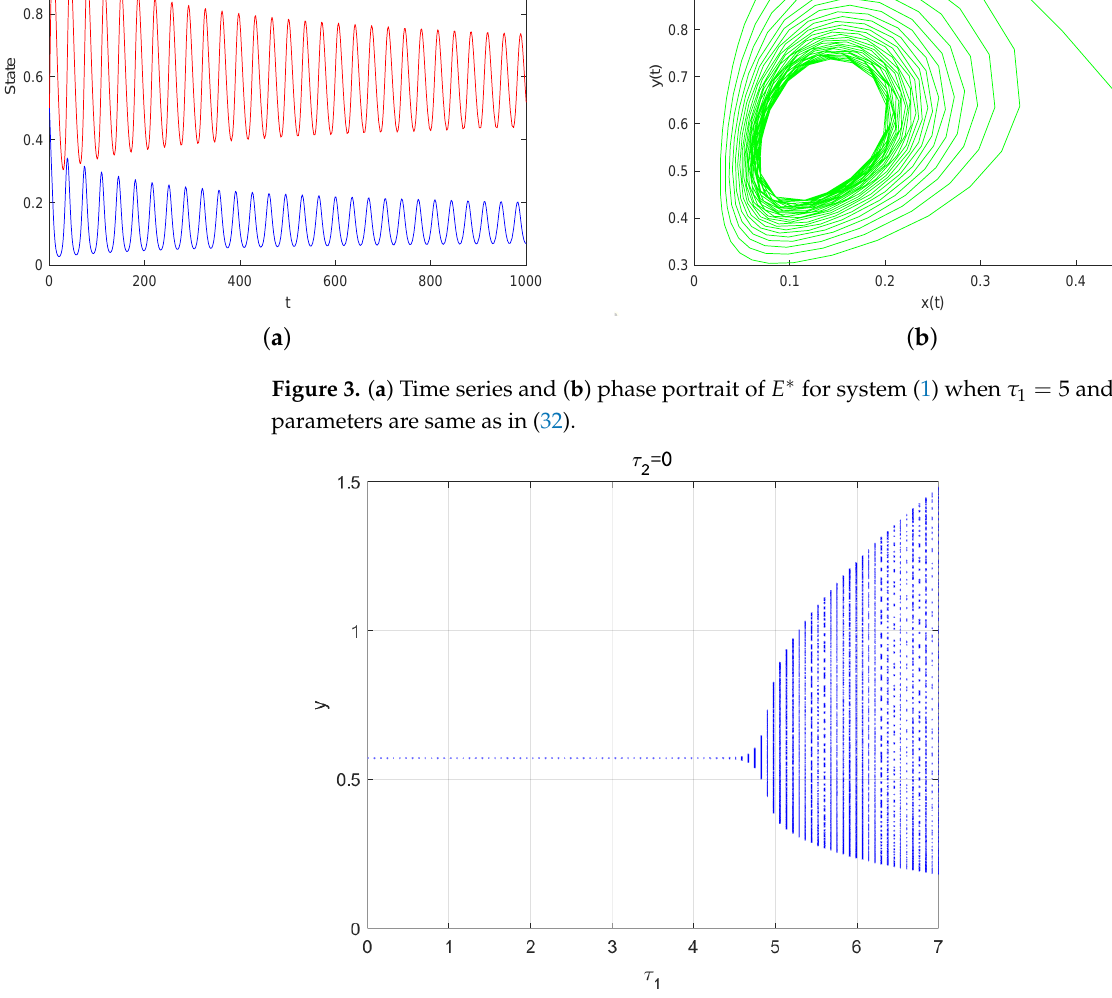
Figure 4. The Hopf bifurcation diagram of (1) for τ 1 and τ 2 =